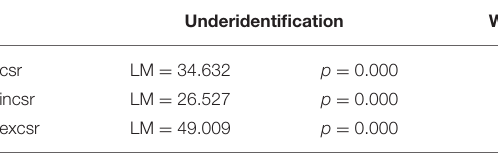
TABLE 9 | Endogeneity test.